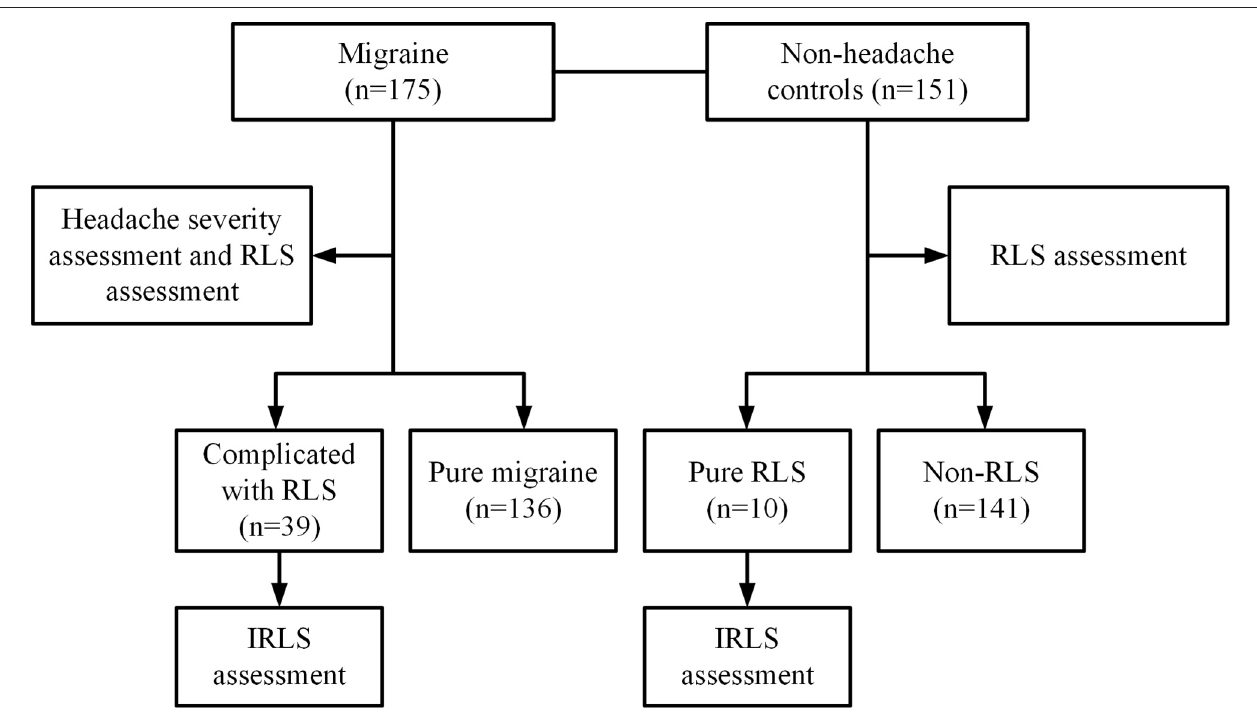
FIGURE 1 | Flow chart of the study. This study collected 175 migraine patients who met the diagnostic criteria of the International Classification of Headache Disorders (ICHD-III b) at the Department of Neurology of the Second Affiliated Hospital of Zhengzhou University from January 2019 to June 2021 and 151 age-matched non-headache controls who underwent physical examinations at the Physical Examination Center during the same period. All subjects were evaluated for RLS. And migraine patients were also evaluated for headache severity. Finally, there were 39 (22.29%) migraine patients complicated with RLS and 136 (77.71%) pure migraine among the migraine patients, and 10 (6.62%) pure RLS and 141 (93.38%) non-RLS subjects among non-headache